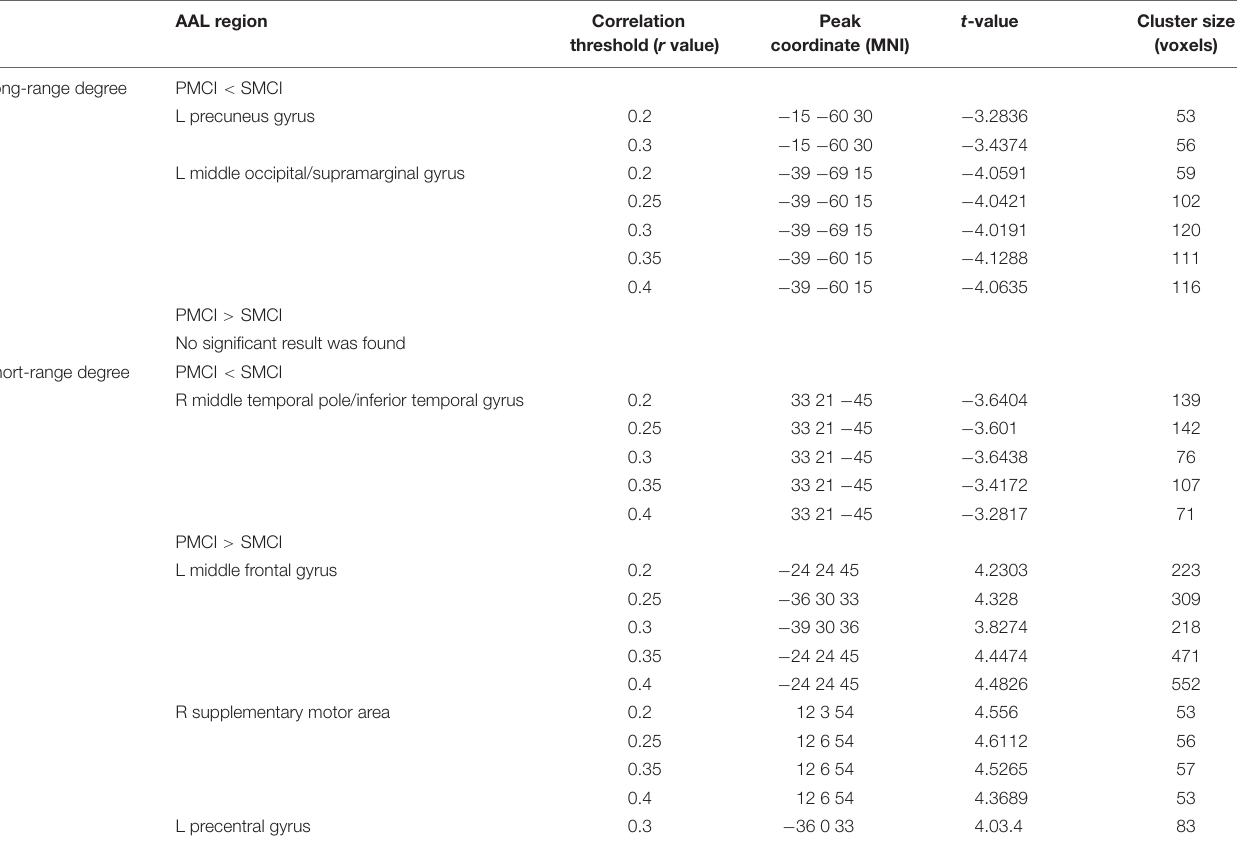
TABLE 2 | Longitudinal degree analysis between PMCI and SMCI groups by controlling the effect of time. AAL region Correlation